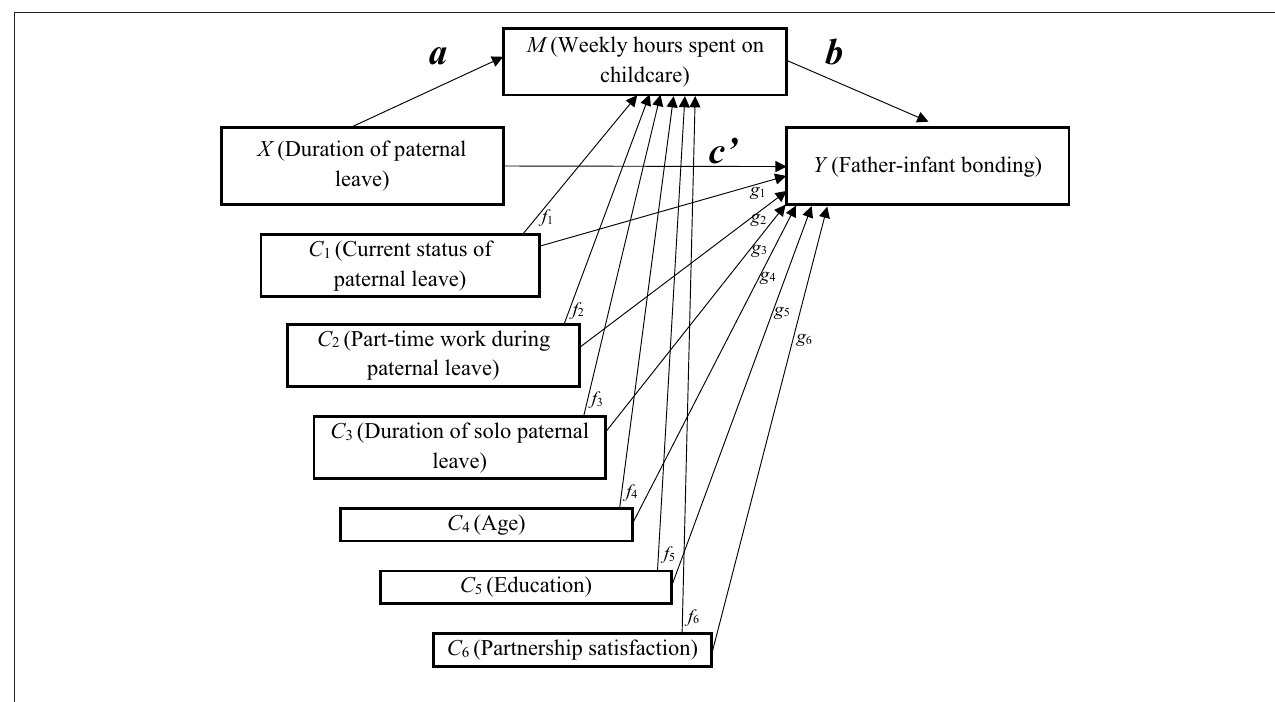
FIGURE 1 | The hypothesized association between duration of paternal leave and father-infant bonding through weekly hours spent on childcare, including six potential confounders. X , predictor variable; M , mediator variable; Y , outcome variable; C 1 − 6 , confounders; a , effect of X on M ; b , effect of M on Y ; ab , indirect effect of X on Y ; c’ , direct effect of X on Y , estimates the difference between X and Y holding M constant; f 1 − 6 , effects of C 1 − 6 on M ; g 1 − 6 , effects of C 1 − 6 on Y